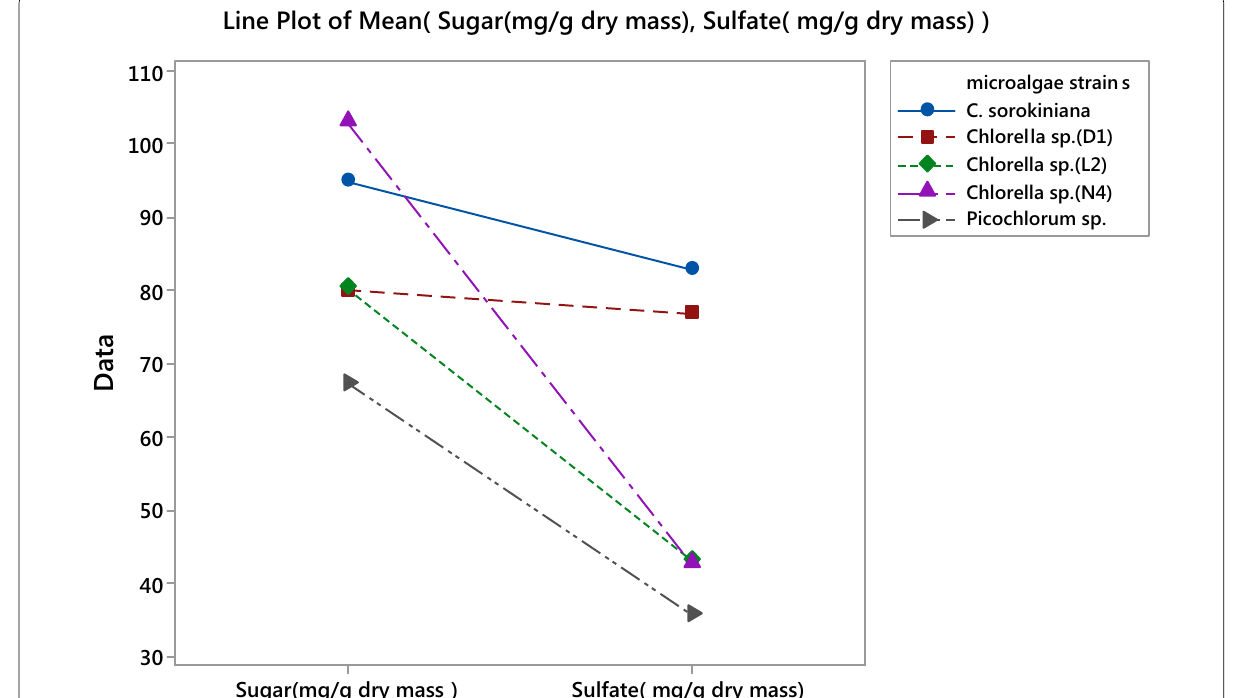
Fig. 4 Comparison of strains in terms of sulfate and sugar content with an emphasis on high sulfate in lower sugar content in EPS extracted of various microalgae strains by line plot of the mean